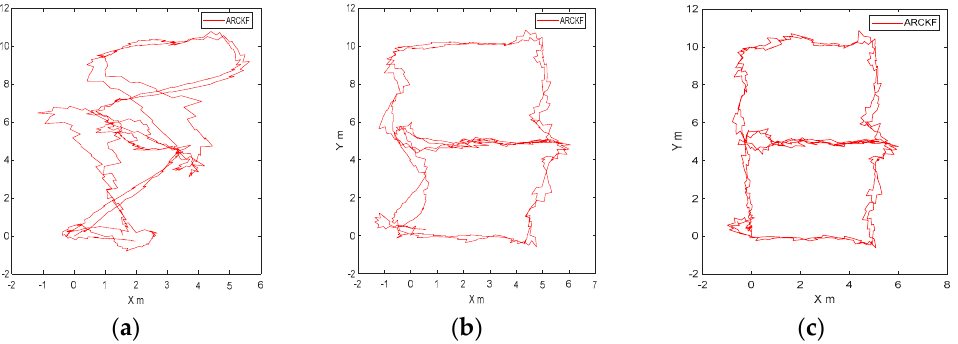
Figure 22. Positioning result of different numbers of beacons for Route 2: ( a ) 2 beacons; ( b ) 3 beacons; ( c ) 4 beacons.